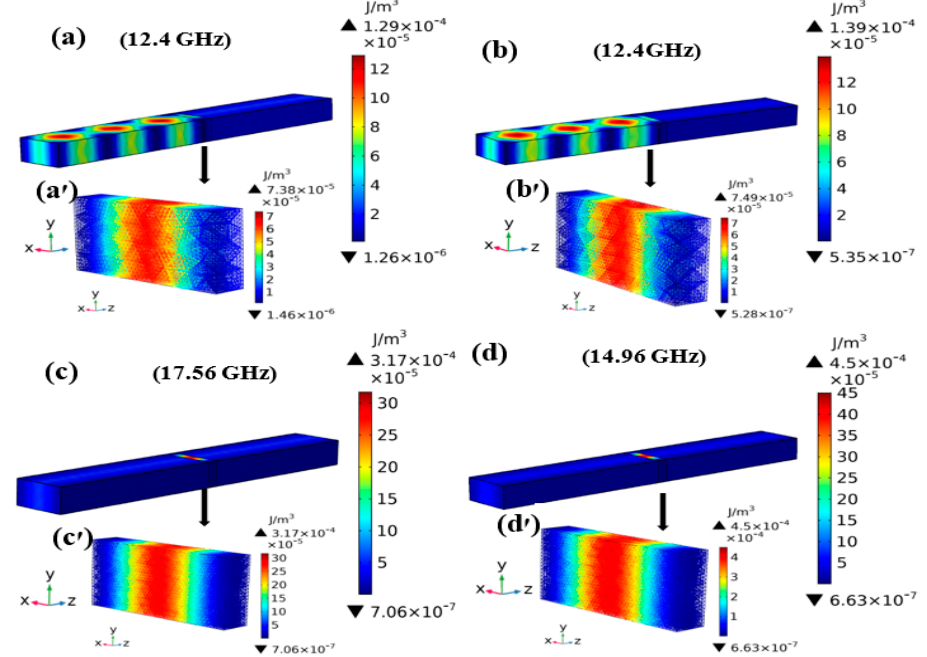
Figure 13. 3D plot EM energy density of Ku-band simulated rectangular waveguide of samples at 3.0 mm thickness at a frequency of (a) 12.4 GHz, (b) 12.4 GHz, (c) 17.56 GHz and (d) 14.96 GHz. The magnified view of EM energy density of region filled with samples at frequency of (a ׳ ) 12.4 GHz, (b ׳ ) 12.4 GHz, (c ׳ ) 17.56 GHz and (d ׳ ) 14.96 GHz.